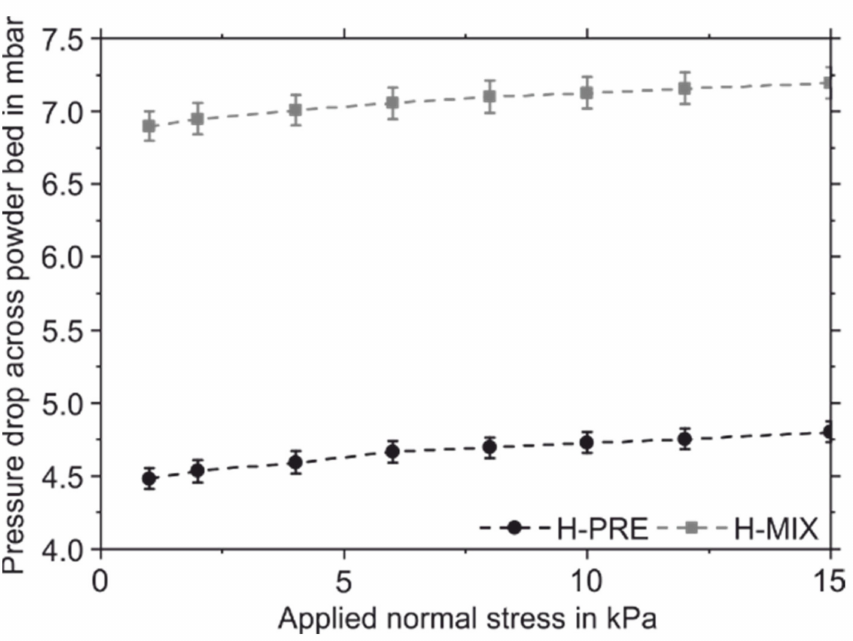
Figure 4. Total energy needed for the movement of the rotating blade into the powder containing vessel of H-PRE and H-MIX.